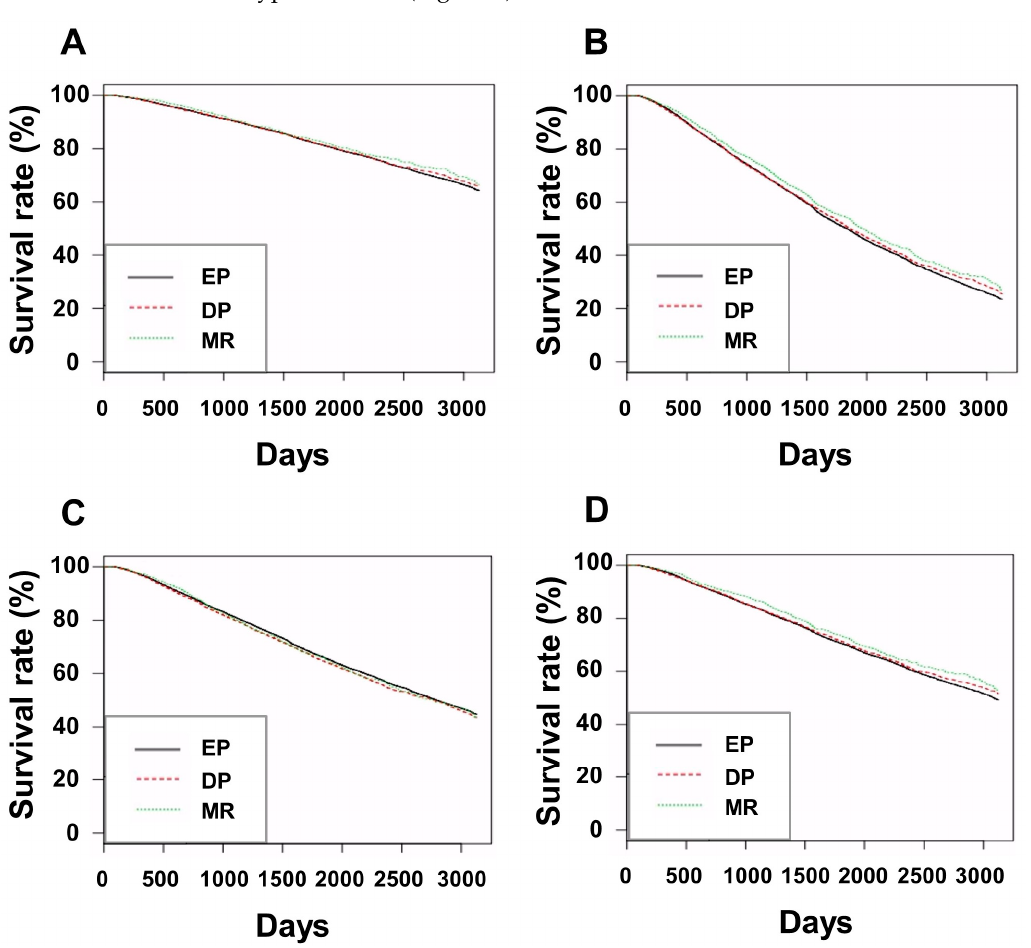
Figure 2. Kaplan–Meier curves of patient survival divided by patients aged <65 years, ( A ), patients aged ≥ 65 years, ( B ), male patients ( C ), and female patients ( D ). For patients aged <65 years, p -values were 0.500 for EP vs. DP group, 0.500 for EP vs. MR group, and 0.500 for DP vs. MR group. For patients aged ≥ 65 years, p -values were 0.244 for EP vs. DP group, 0.036 for EP vs. MR group, and 0.118 for DP vs. MR group. For male patients, p -values were 0.087 for EP vs. DP group, 0.615 for EP vs. MR group, and 0.615 for DP vs. MR group. For female patients, p -values were 0.230 for EP vs. DP group, 0.160 for EP vs. MR group, and 0.230 for DP vs. MR group. Abbreviations: EP, group treated with short-acting erythropoiesis-stimulating agents; DP, group treated with intermediate-acting erythropoiesis-stimulating agents; MR, group treated with long-acting erythropoiesis-stimulating agents.